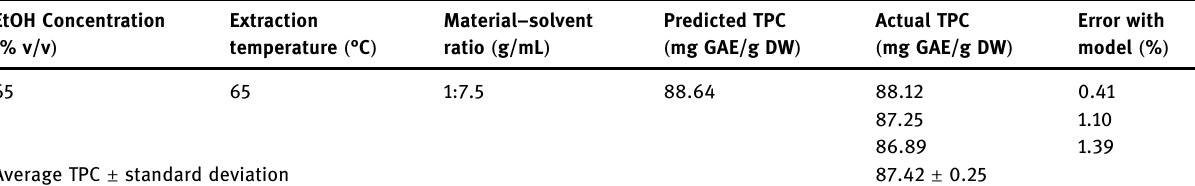
Table 4: The results of optimum condition experiment EtOH Concentration ( % v/v